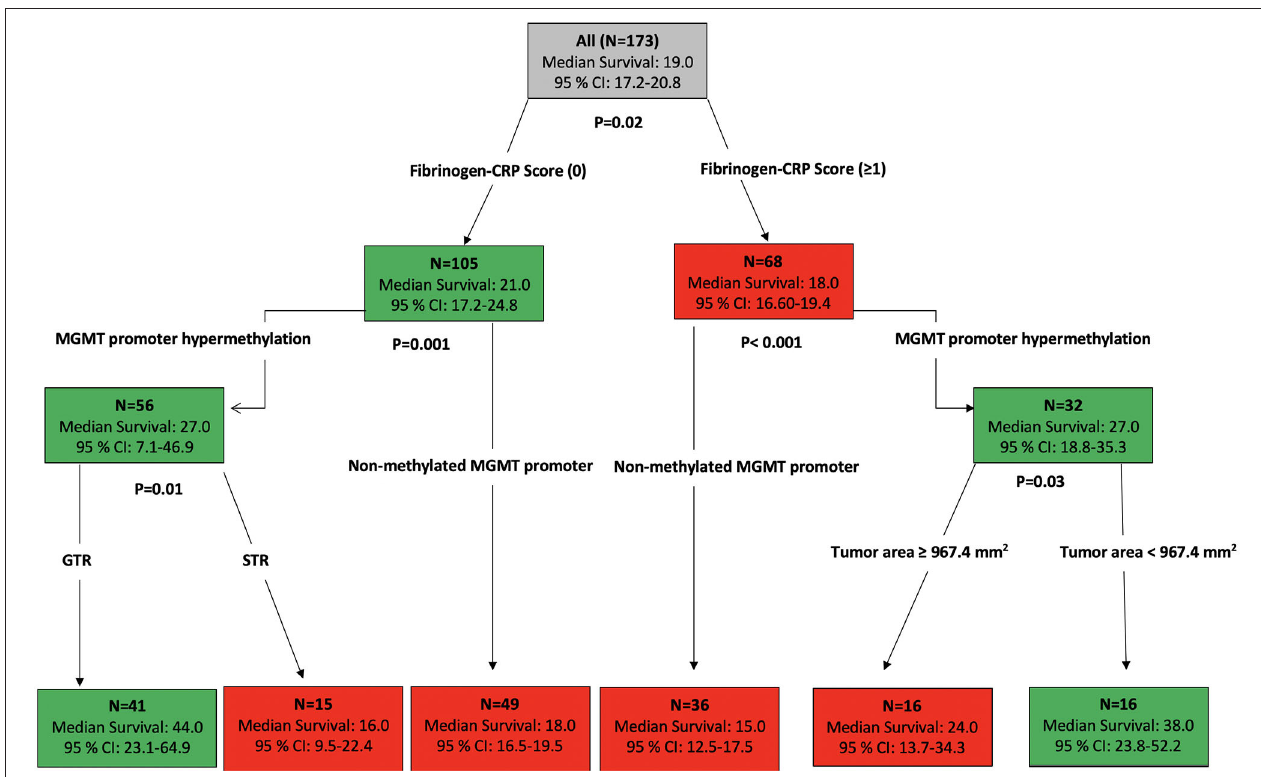
FIGURE 4 | Primary stratification tree that presents the cohorts prognoses. Each colored box represents the specified subgroup with the number of patients, median OS in months, and 95% confidence interval. The green boxes indicate the subgroups of patients with good survival prognosis, whereas the red boxes represent the patients with poor prognosis. The entire patient cohort was first divided into fibrinogen–CRP score (0) vs. fibrinogen–CRP score ( ≥ 1), which showed an increase of 3 months in overall survival among patients with an FC score of 0 compared to patients with an FC score ≥ 1. The hypermethylated MGMT promoter status is an independent predictor of prolonged survival in both groups. The additional stratification of patients with an FC score of 0 whose MGMT promoters were hypermethylated revealed that the GTR in these patients increased their OS to 44 months (95% CI: 23.1–64.9), whereas further stratification of the patients with an FC score ≥ 1 whose MGMT promoters were not hypermethylated revealed a median OS of 15 months (95% CI: